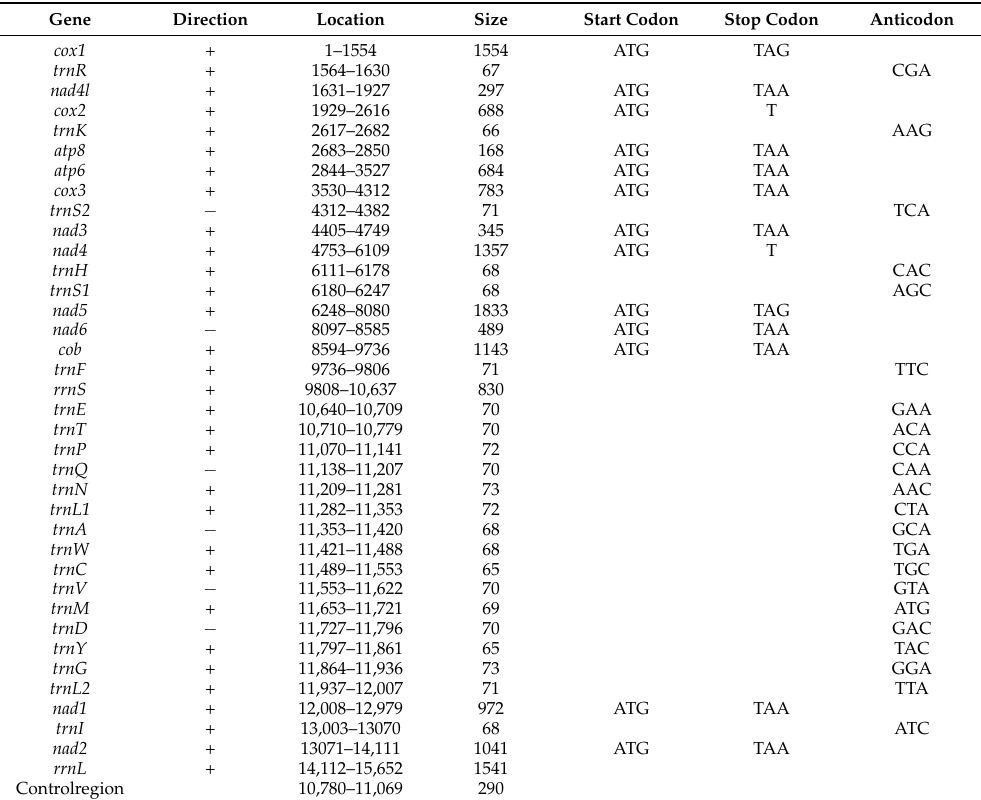
Table 3. Characteristic features of the mitochondrial genome of B. argus